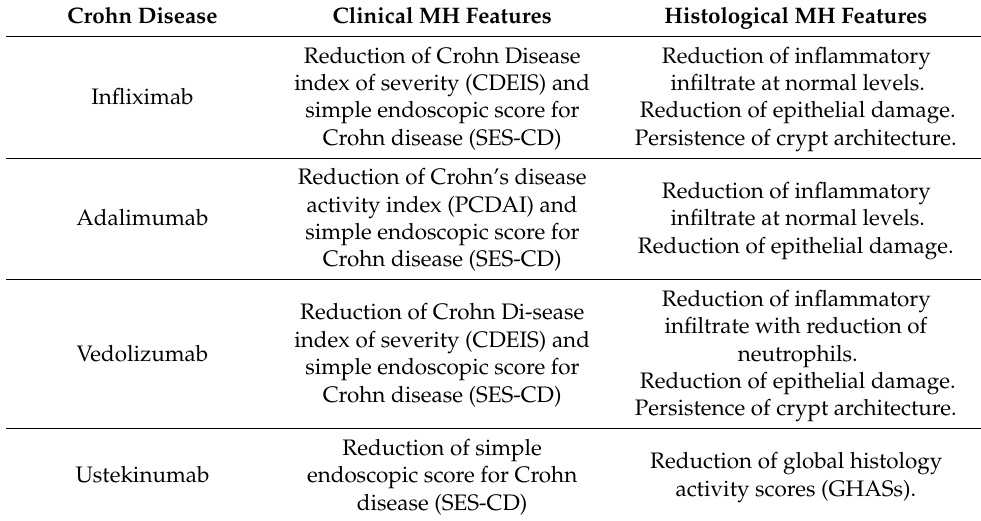
Table 4. Main histological features in MH described in monoclonal antibodies therapy in IBD. Crohn